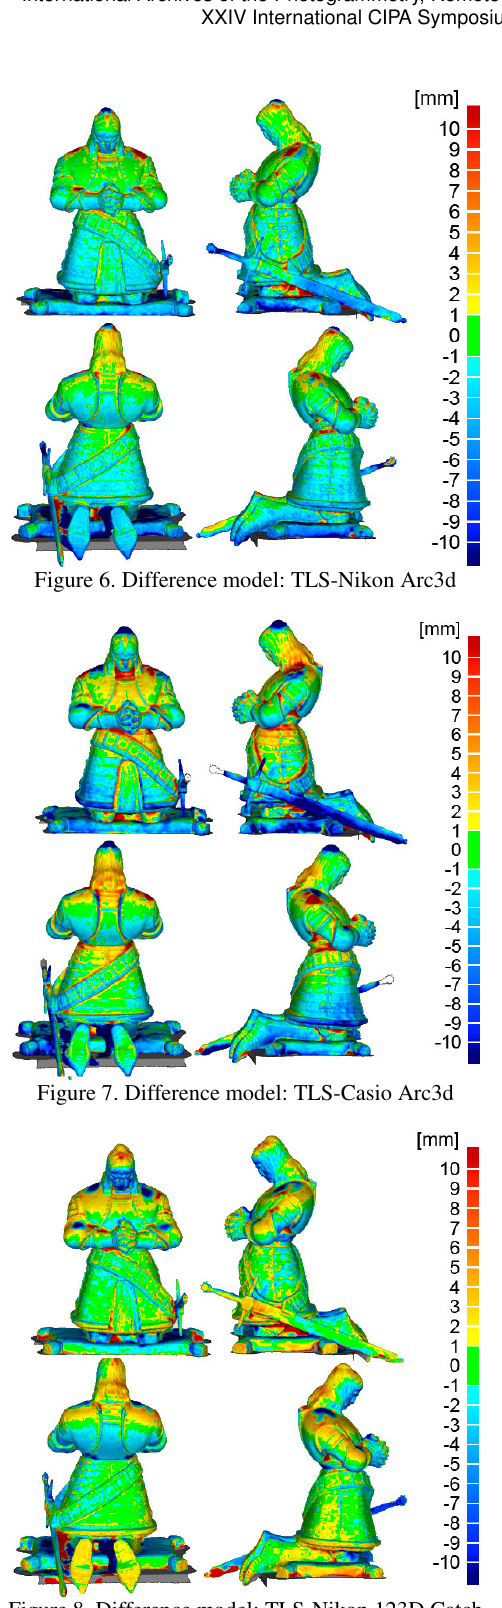
Figure 8. Difference model: TLS-Nikon 123D Catch